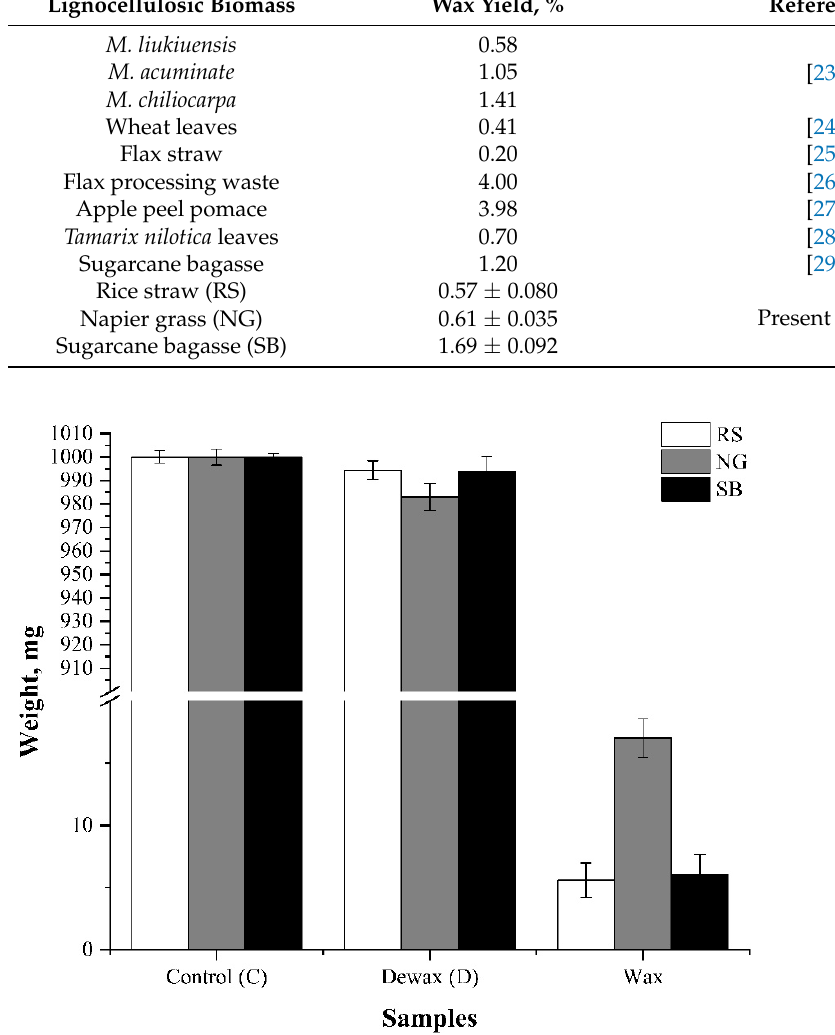
Figure 1. Wax yields of three types of biomass. RS—rice straw; NG—Napier grass; SB—sugarcane bagasse. Table 1. Wax from different lignocellulosic biomass types extracted using n-hexane solvent.